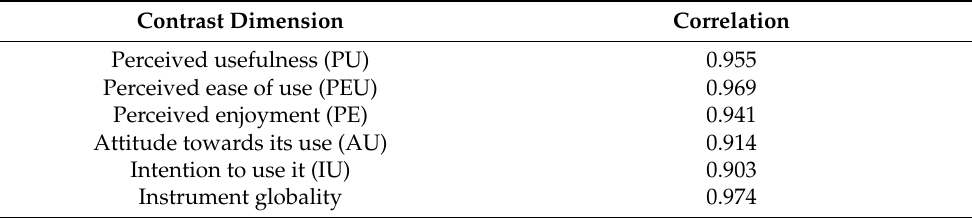
Table 6. Correlations between the scores achieved by the two objects in each dimension. Source: developed by the authors.